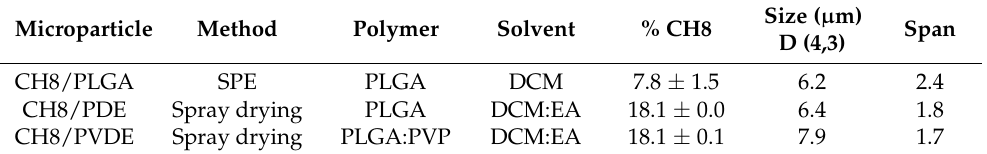
Table 1. Microparticle